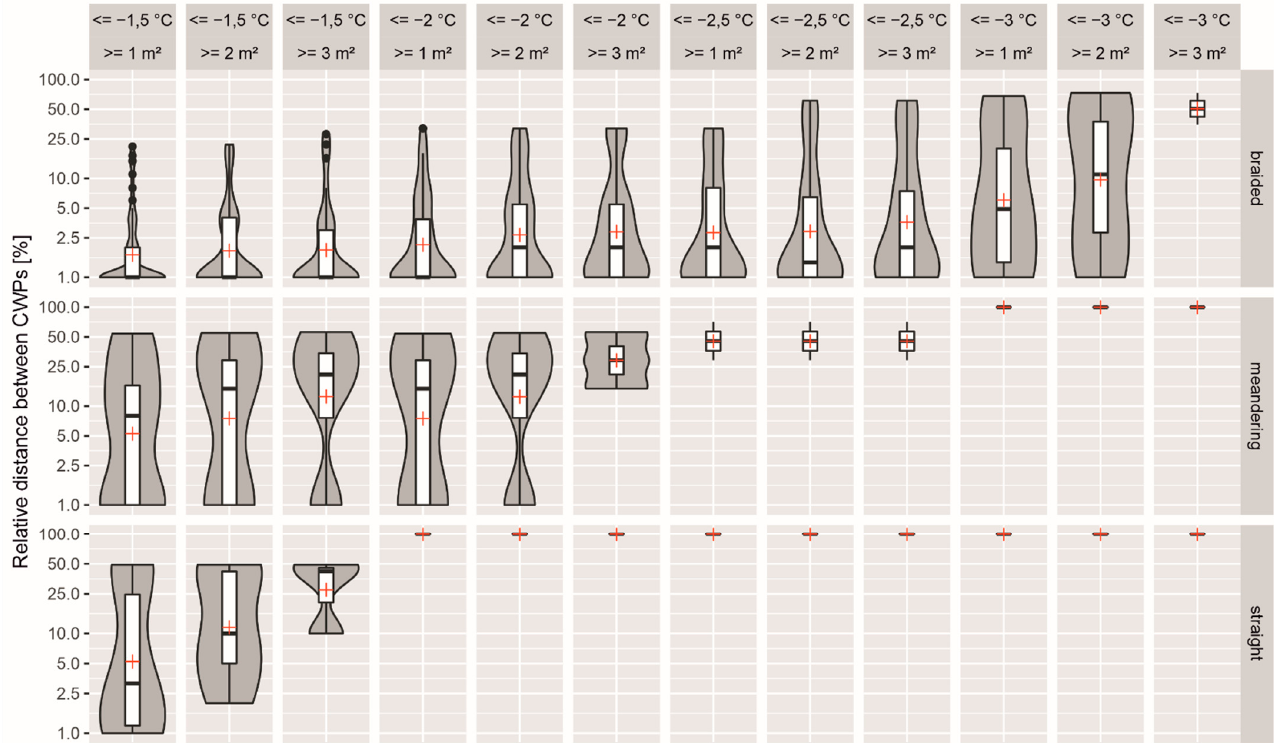
Figure 6. Combined violin and boxplots of distances between CWPs for each selected LOI or survey section. CWPs are identified by different definitions of patch size and relative temperature thresholds. A 100% distance indicates that no CWP was present for a specific metric definition. Boxes indicate the 25–75% quantiles, with the horizontal line in bolt representing the median. Red crosses indicate mean values. Whiskers indicate the minimum and maximum values. The violin plot outlines illustrate kernel probability density, and the grey area’s width represents the proportion of data points.